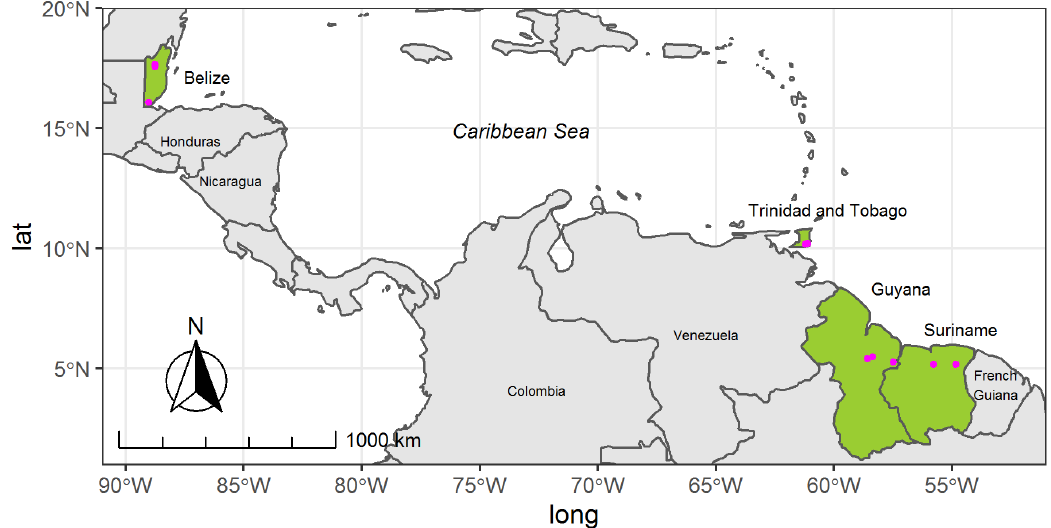
Table 1. Characteristics of future crop trees (FCTs) ([35], modified).